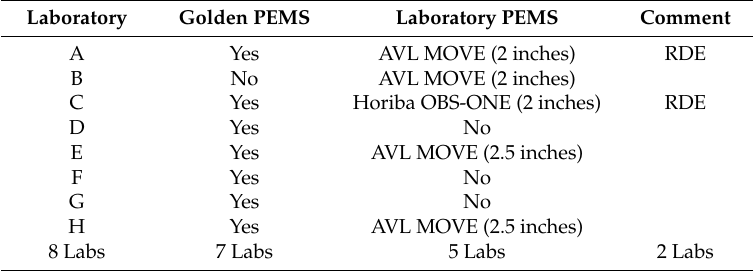
Table 1. Test protocol in chronological order. Golden Portable Emissions Measurement Systems (PEMS) is the OBS-ONE (2 inches) (Horiba, Kyoto, Japan). The number in brackets indicates the exhaust flow meter diameter. All laboratories repeated 3 times the World harmonized Light-duty Test Cycle (WLTC), except E (2 repetitions). RDE means that a Real-Driving Emissions cycle was additionally conducted in the laboratory. MOVE is the PEMS from AVL (Graz,